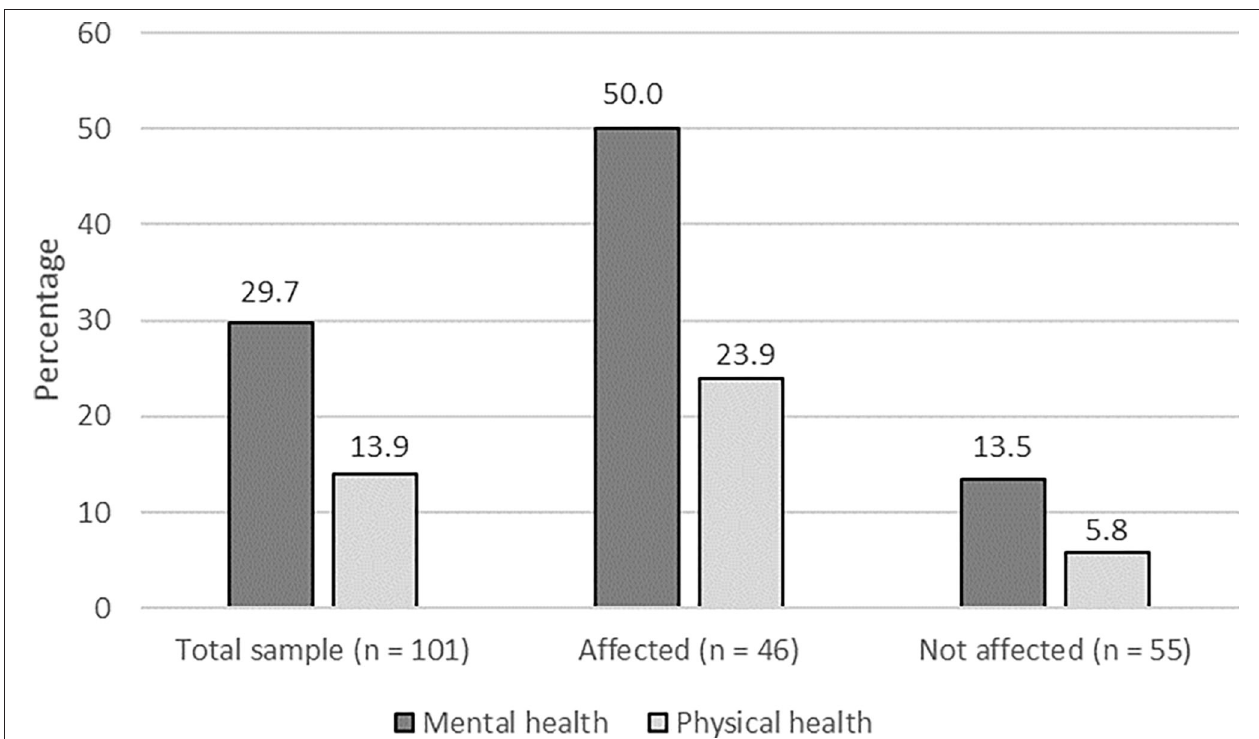
FIGURE 1 | Declaration of the impact of coastal hazards on the health of respondents according to their